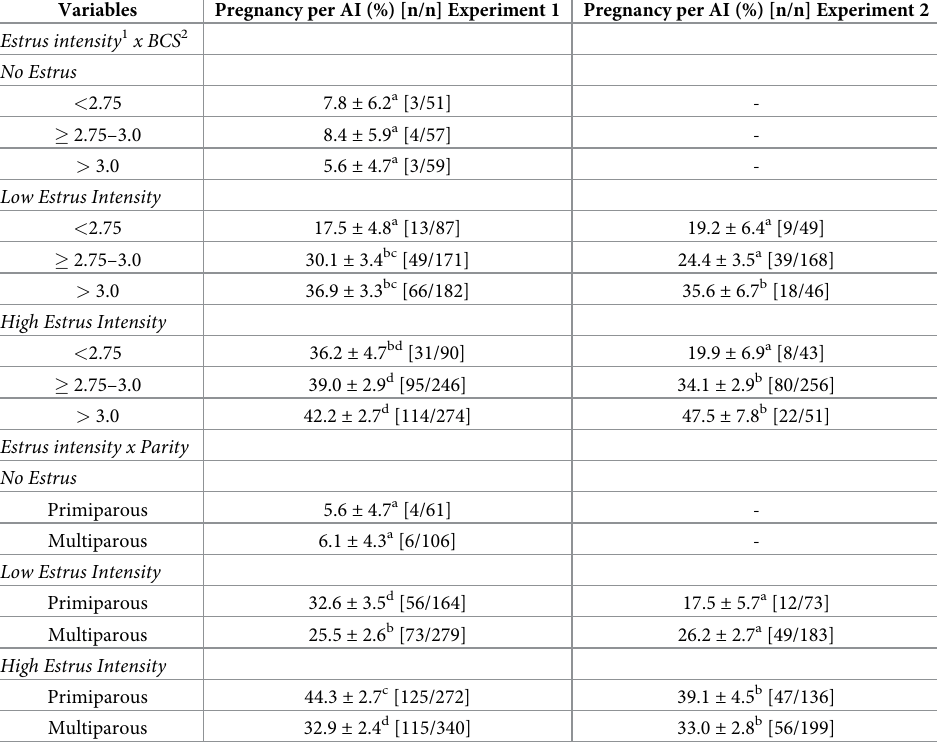
Table 4. Pregnancy per AI, in both Experiment 1 and Experiment 2, according to the interactions of estrus inten- sity and body condition score and the interaction of estrus intensity and parity.